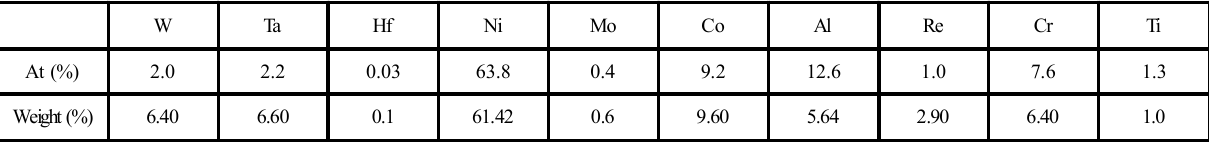
TABLE 1. THE CHEMICAL COMPOSITION OF CMSX-4 SUPERALLOY (CANNON-MUSKEGON CORPORATION, USA) THAT WAS USED IN THIS